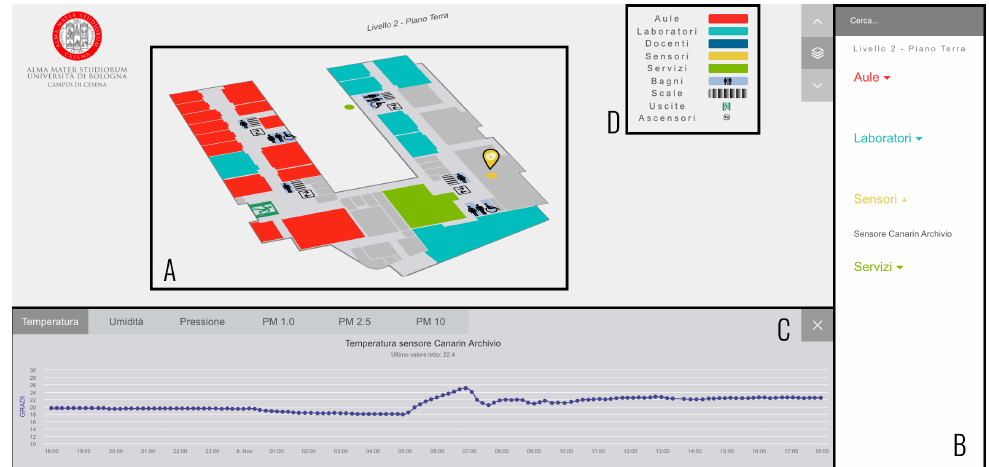
Figure 2. The system interface displayed when a user clicks on a sensor. ( A ) represents the floor where the sensor is located; ( B ) represents the sidebar with all the PoIs listed; ( C ) represents the historical visualization of the temperature data gathered by an indoor sensor; ( D ) represents the legend with all the space typologies (e.g., classrooms, laboratories, offices,